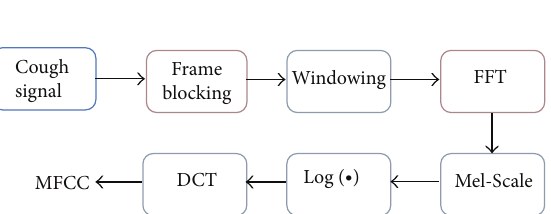
Figure 2: Classifier model.